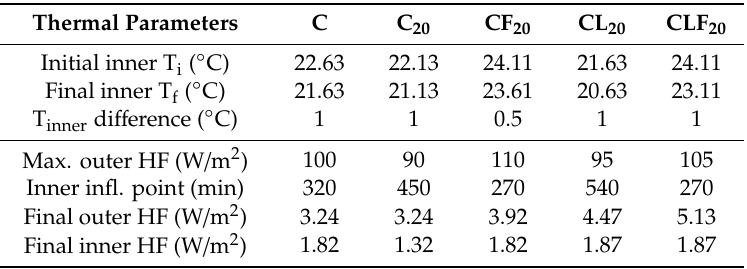
Table 6. Summary of temperature and heat flux main results on both sides of the brick wall enclosure with PCM cement-lime mortar layer during a cooling